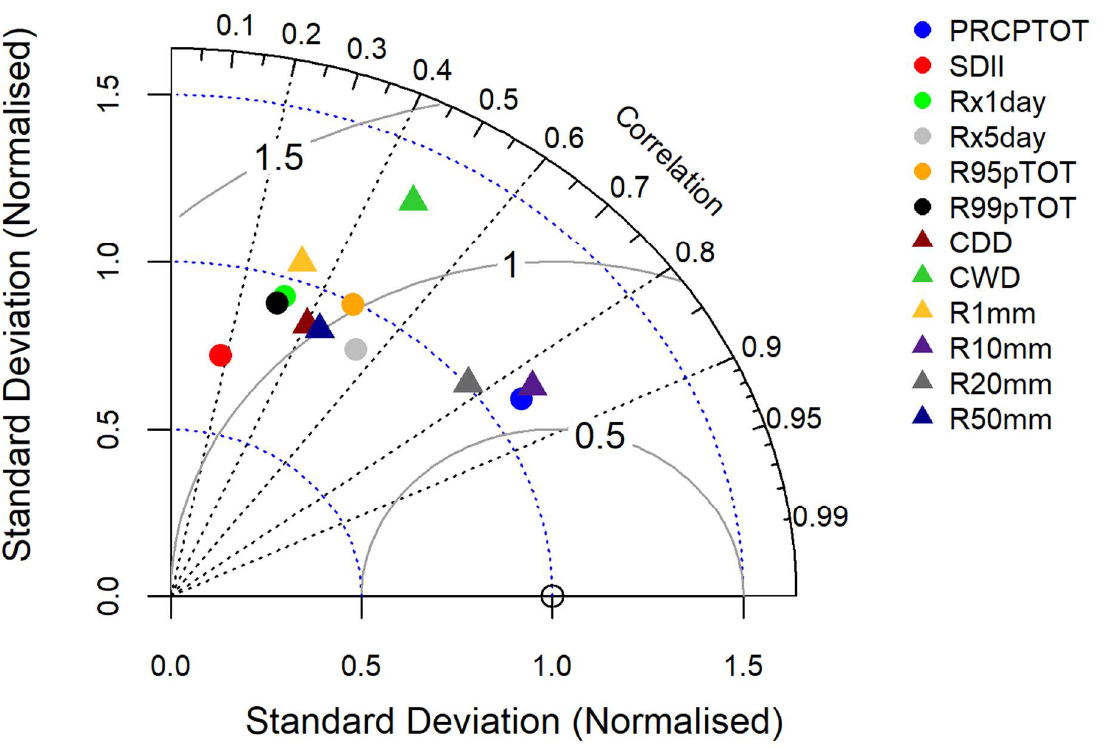
Figure 8. Statistical comparison between climate indices from the Taylor diagram. RMSE is represented with curved lines in gray, STD is represented with curved lines in blue, and r is represented with straight lines in black.